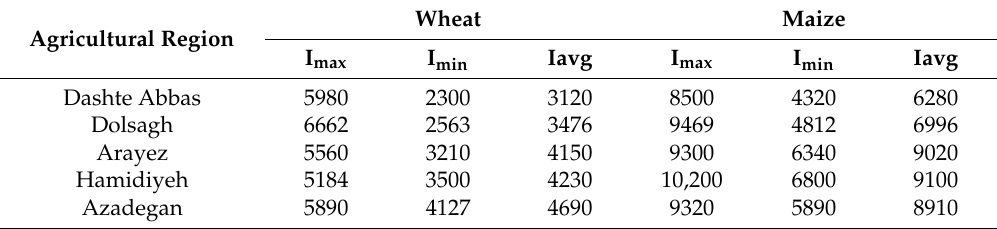
Table 4. Results of the SM model for irrigation water applied to wheat and maize (m 3 ·ha − 1 ) in LKRB. Wheat Maize Agricultural Region I max I min